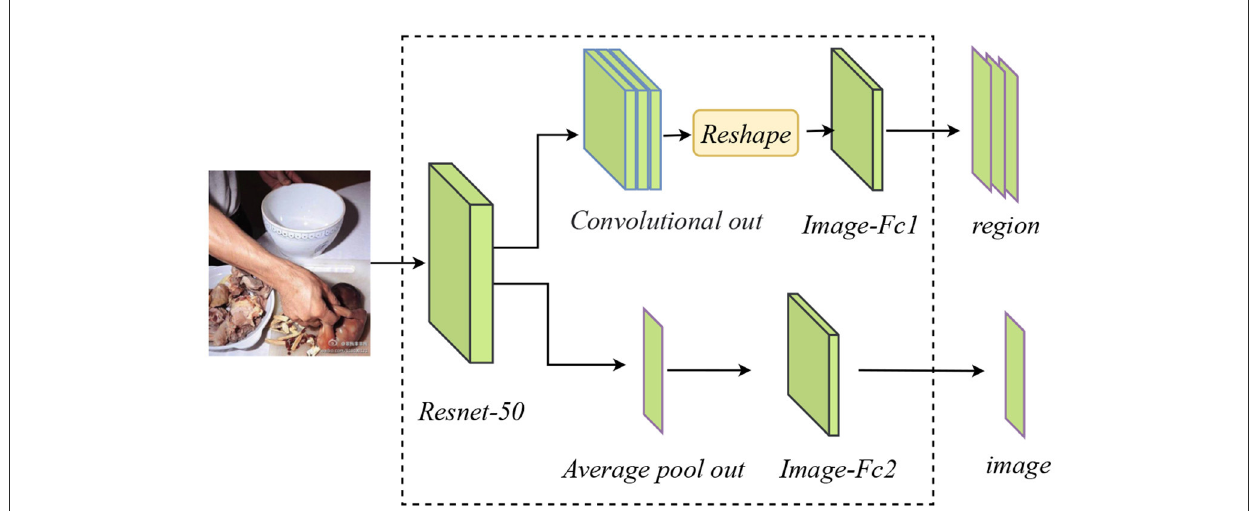
FIGURE3 Image feature extractor module. It contains two branches, the upper branch is used to extract regional information ( V m in Figure 1) for multimodal fusion and the lower branch is used to extract overall deep image information ( V f in Figure 1).